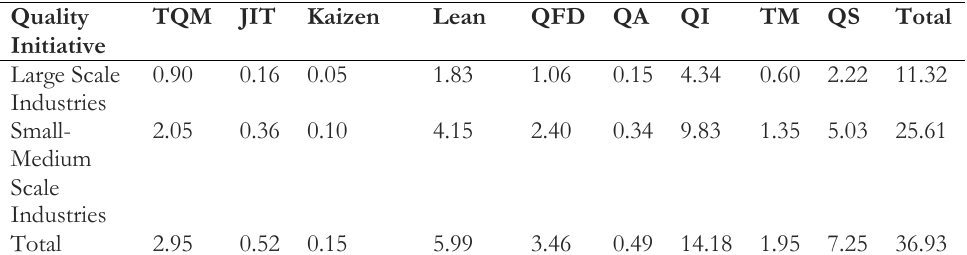
Table 3. Chi-square values computed for quality